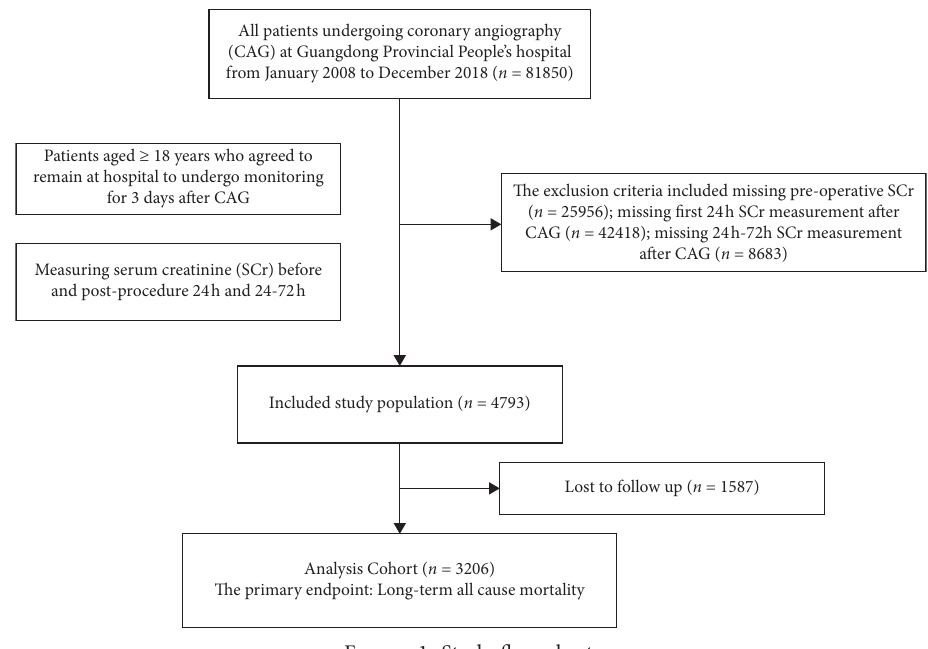
Figure 1: Study flow